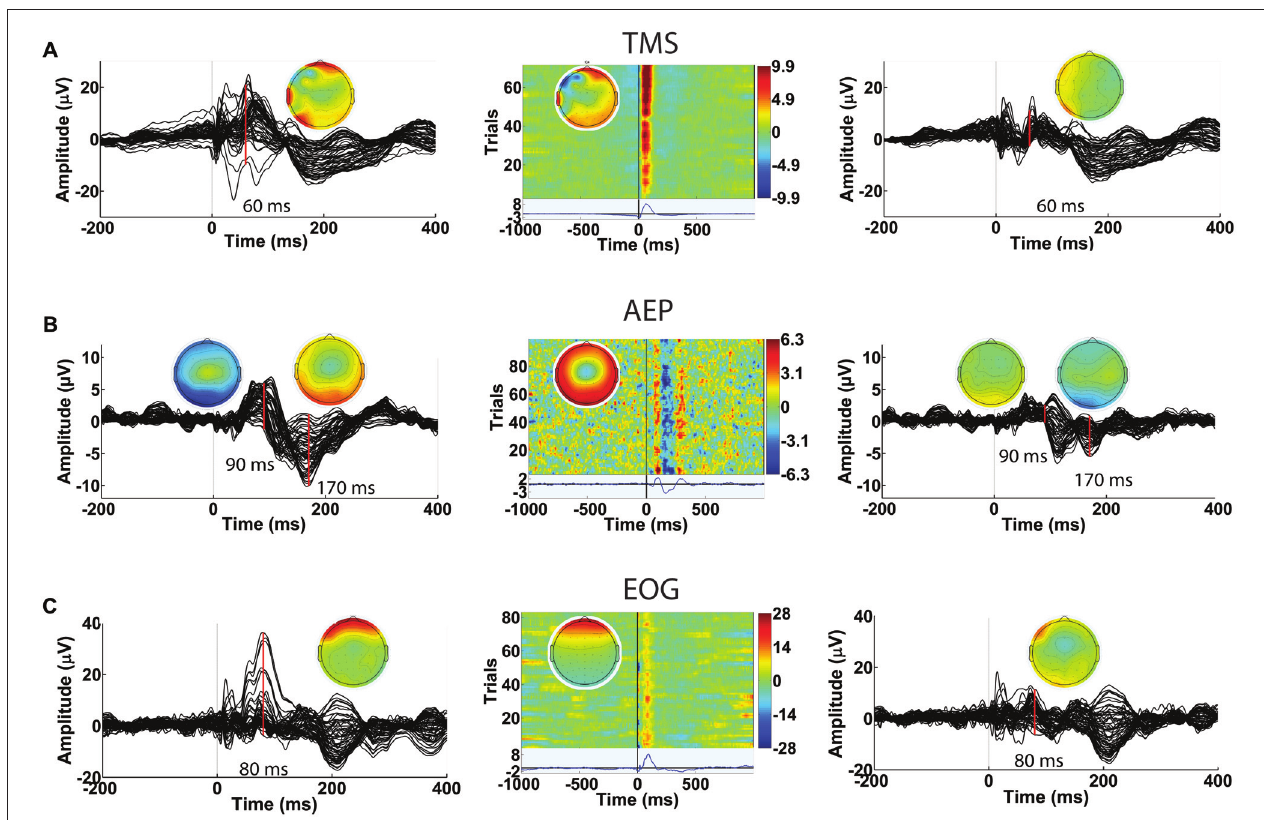
FIGURE 12 | Examples of artifacts that can be identified in Round 2 of ICA in Step 8. In each row, the left panel depicts the average butterfly plot of the TEPs before removing the artifact ( x -axis represents time in ms relative to presentation of TMS pulse and y -axis represents the amplitude of the EEG signal in µ V). The center panel displays the ICA component associated with the artifact ( x -axis represents time in milliseconds relative to presentation of TMS pulse, y -axis represents the trial number and a color scale is used to depict the amplitude of the ICA component in µ V). The right panel shows the averaged butterfly plot of the TEPs after removing the artifact ( x -axis represents time in milliseconds relative to presentation of TMS pulse and y -axis represents the amplitude of the EEG signal in µ V). Topographical maps in each panel illustrate the scalp projection of the artifactual component at the latency of the artifact. Rows illustrate the impact of removing (A) a residual TMS artifact with latency of 60 ms (identified in data collected during suprathreshold single pulse TMS applied to the left dorsolateral prefrontal cortex [DLPFC]), (B) auditory evoked potential (AEP) with latency of 90 ms and 170 ms (identified in data collected during suprathreshold single pulse sham TMS applied to the left motor cortex), and (C) eye blink artifact with latency of 80 ms (identified in data collected during suprathreshold single pulse TMS applied to the left DLPFC).